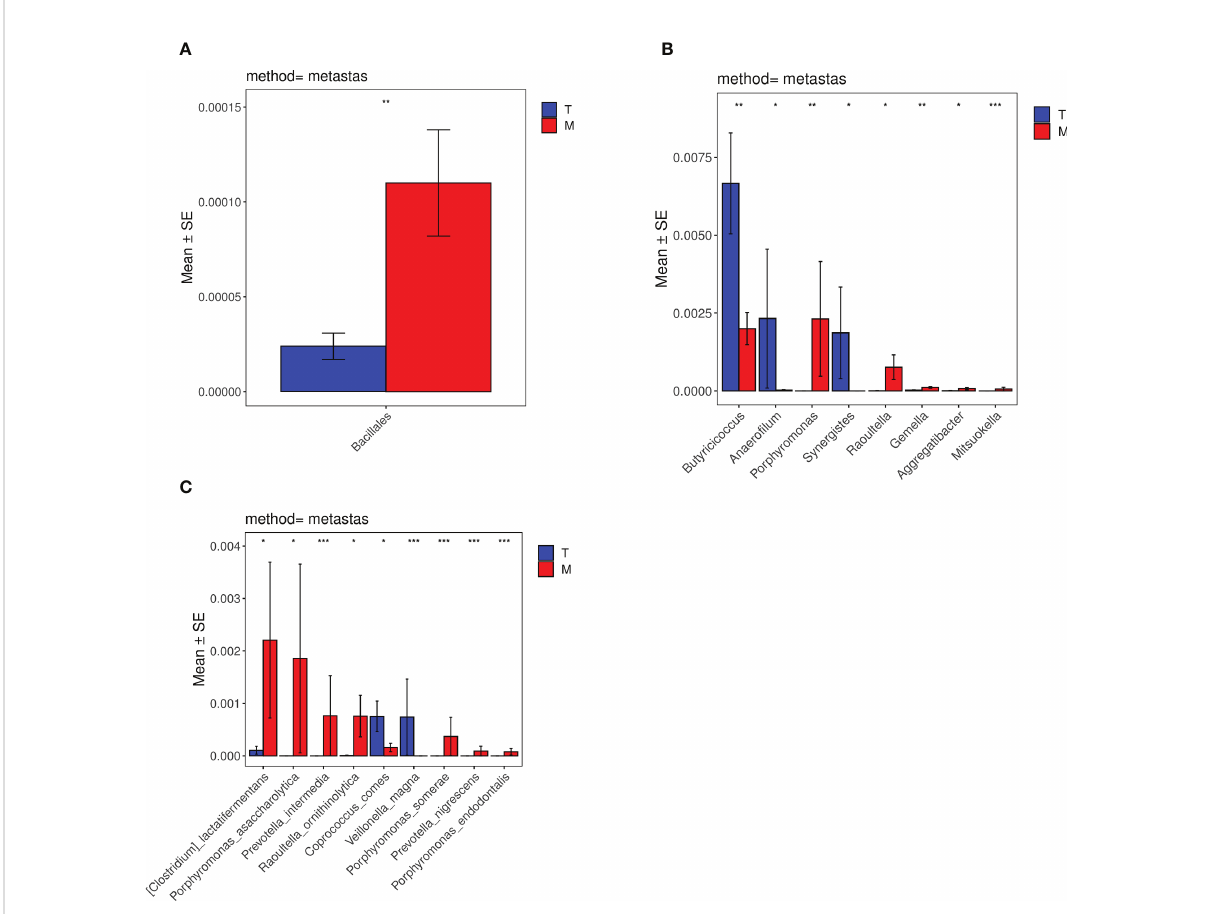
FIGURE 7 Histograms of distribution differences of species between the tumor without metastases group and the metastases group performed by Metastats software at the levels of order (A) , genus (B) and species (C) . *p < 0.05, **p < 0.01, ***p < 0.001, ****p <